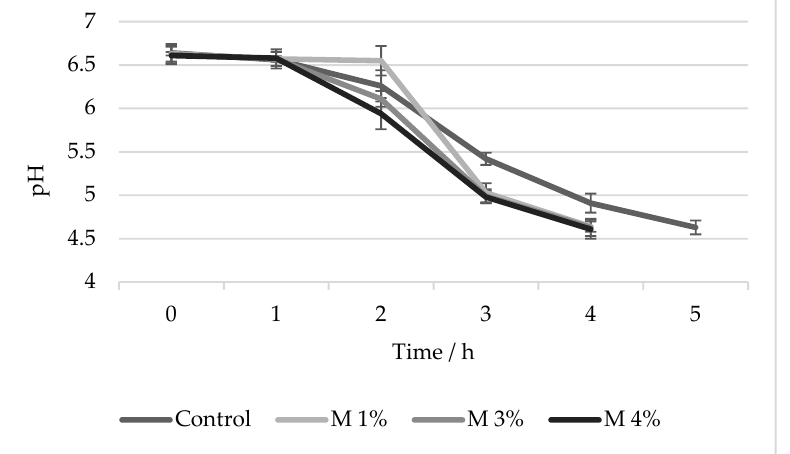
Figure 1. pH values measured during fermentation time (h) in control sample (Control) and samples with ME addition (1, 3 and 4% of extract addition, M 1%, M 3%, M 4%). Results are expressed as mean values and error bars show SD. Table 1. pH values measured during cold storage (1st, 7th, 14th, 21st and 28th day) in control sample (Control) and samples with moringa extract addition (1, 3 and 4% of extract addition, M 1%, M 3%, M